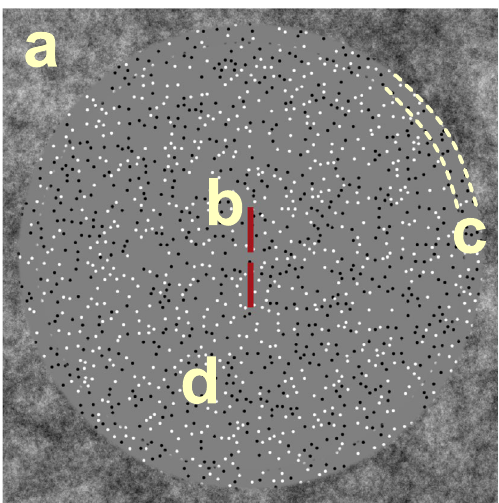
Figure 6. Schematic illustration of the DRDS display. A binocular, zero-disparity frame comprising 1/f noise ( a ) was used as a fusion lock. Dichoptic nonius lines ( b ) were used to engage fixation at the center of the screen and to monitor vergence. A detection task in which the color of the nonius lines changed from red to blue occurred at random intervals during both ‘attend fixation’ and ‘attend stimulus’ conditions. It was task relevant only in the ‘attend fixation’ condition. The duration of the color change was varied on a staircase which maintained an 82% detection rate. To minimize the availability of disparity references, a 1-degree gap containing binocularly uncorrelated dots ( c ) was interposed between the changing disparity region ( d ) and the fusion lock ( a